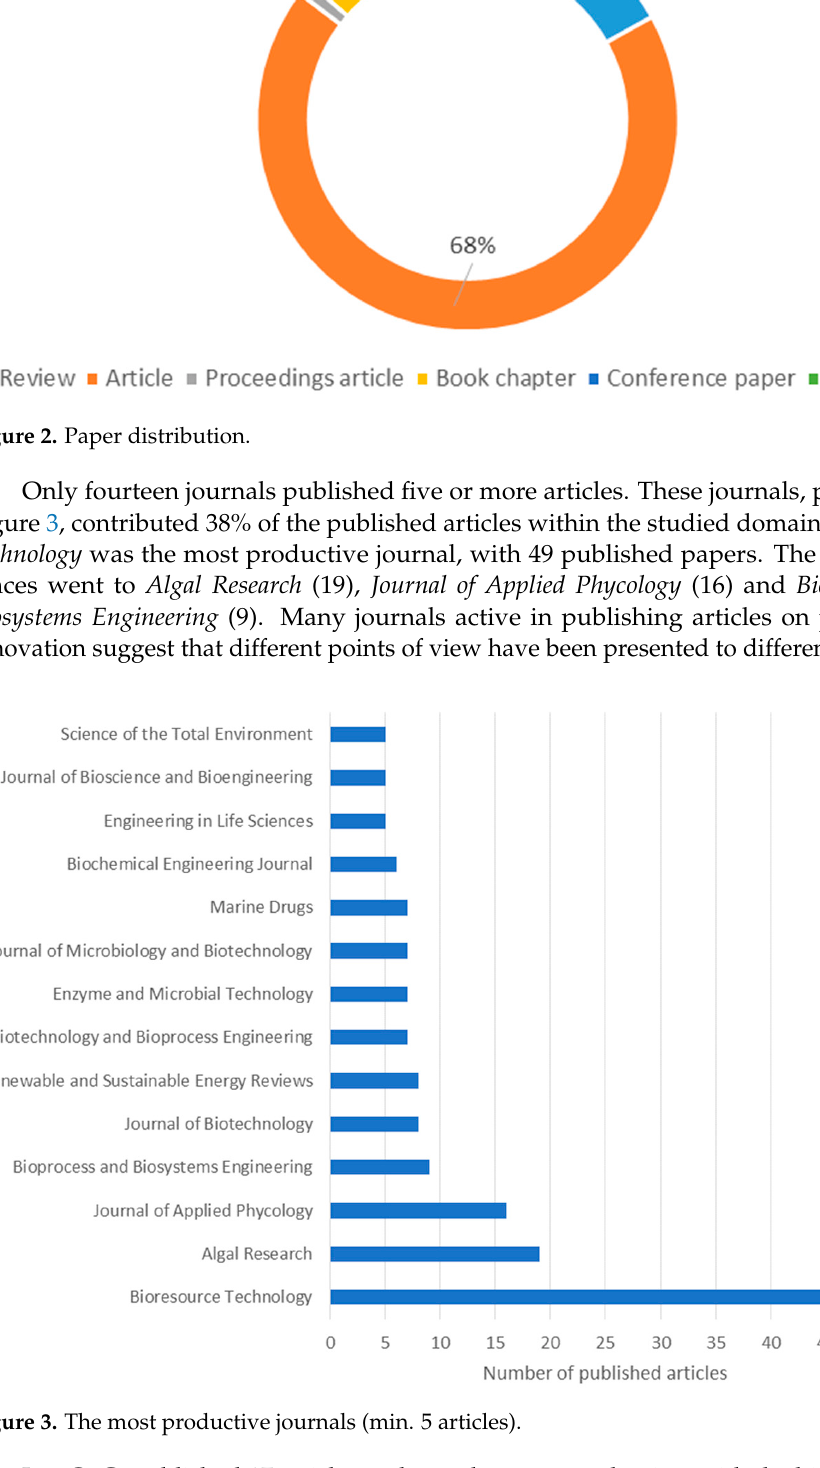
Figure 3. The most productive journals (min. 5 articles).